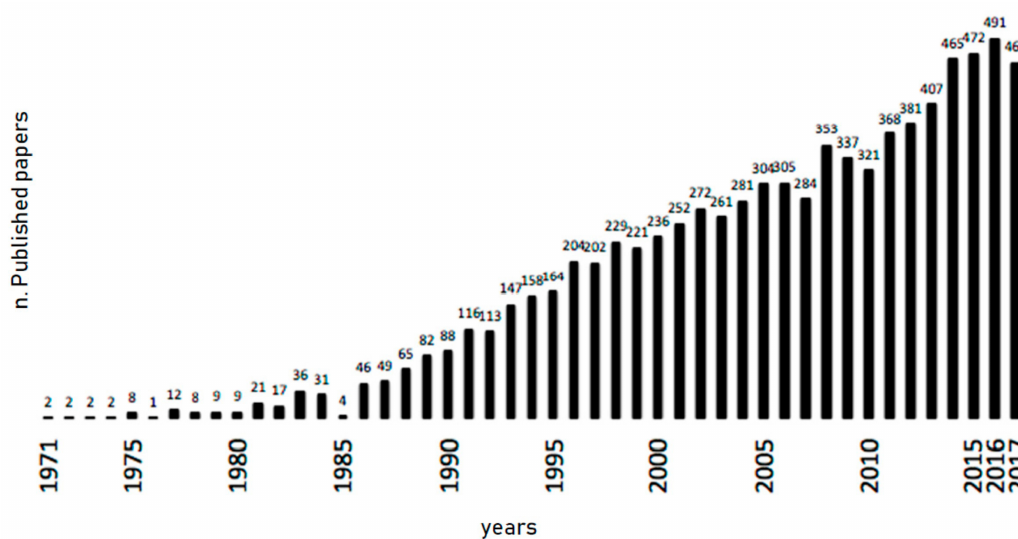
Figure 2. PubMed (U.S. National Library of Medicine, Medical Institutes of Health) records on academic publications on Gal-3, total 8289 items by December 2017. Search Strategy MESH terms: Galectin 3 or Gal-3 or Advanced Glycation End-Product Receptor 3 or Lectin, Galactoside-Binding, Soluble, 3 or Carbohydrate-Binding Protein 35 (CBP 35) or Galactose-Specific Lectin 3 or Laminin-Binding Protein or IgE-Binding Protein or Lectin